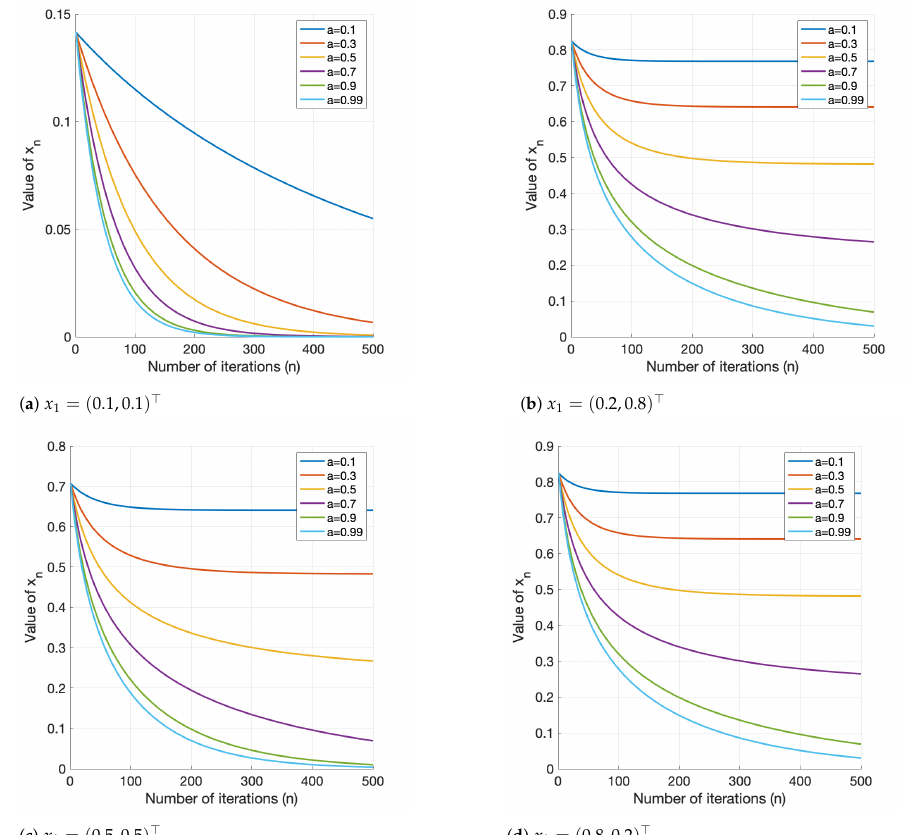
Figure 3. The behavior of the iterate x n for different values of the initial point x 1 when performed by APGM with various values for a .